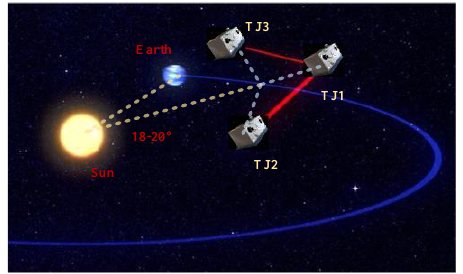
Figure 10. Schematic diagram of TaiJi.